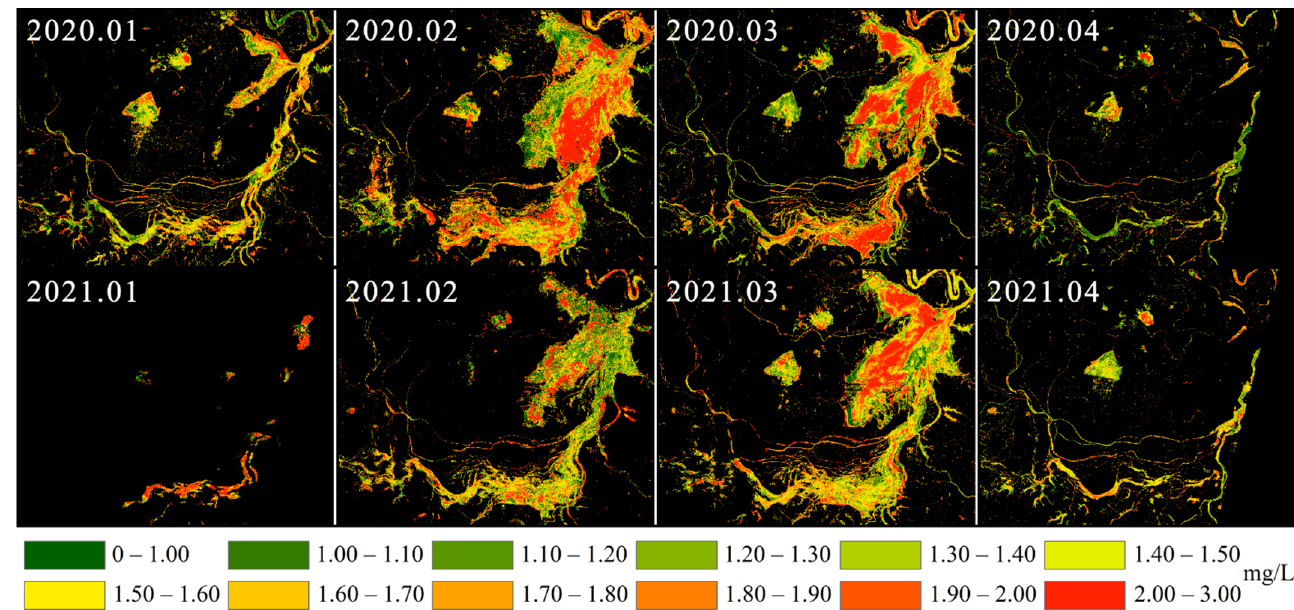
Figure A2. Quarterly distribution of TN in Dongting Lake.